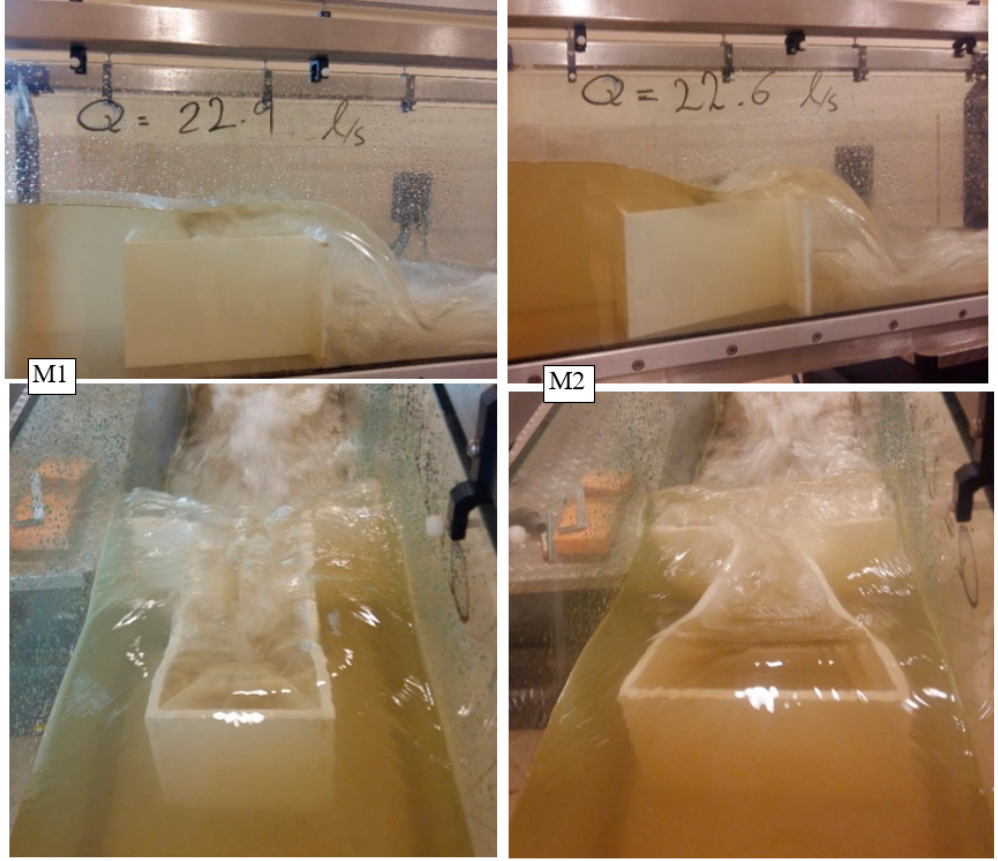
Figure 14. Flow characteristics for M1 and M2 models, Q = 0.0226 m 3 /s for M1 model, and Q = 0.0229 m 3 /s for M2 model.